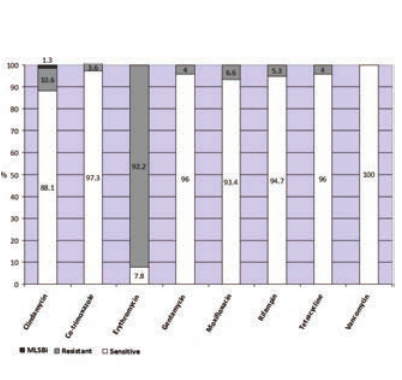
Figure 2. Sensitivity pattern for communi- ty acquired methicillin staphylococcus